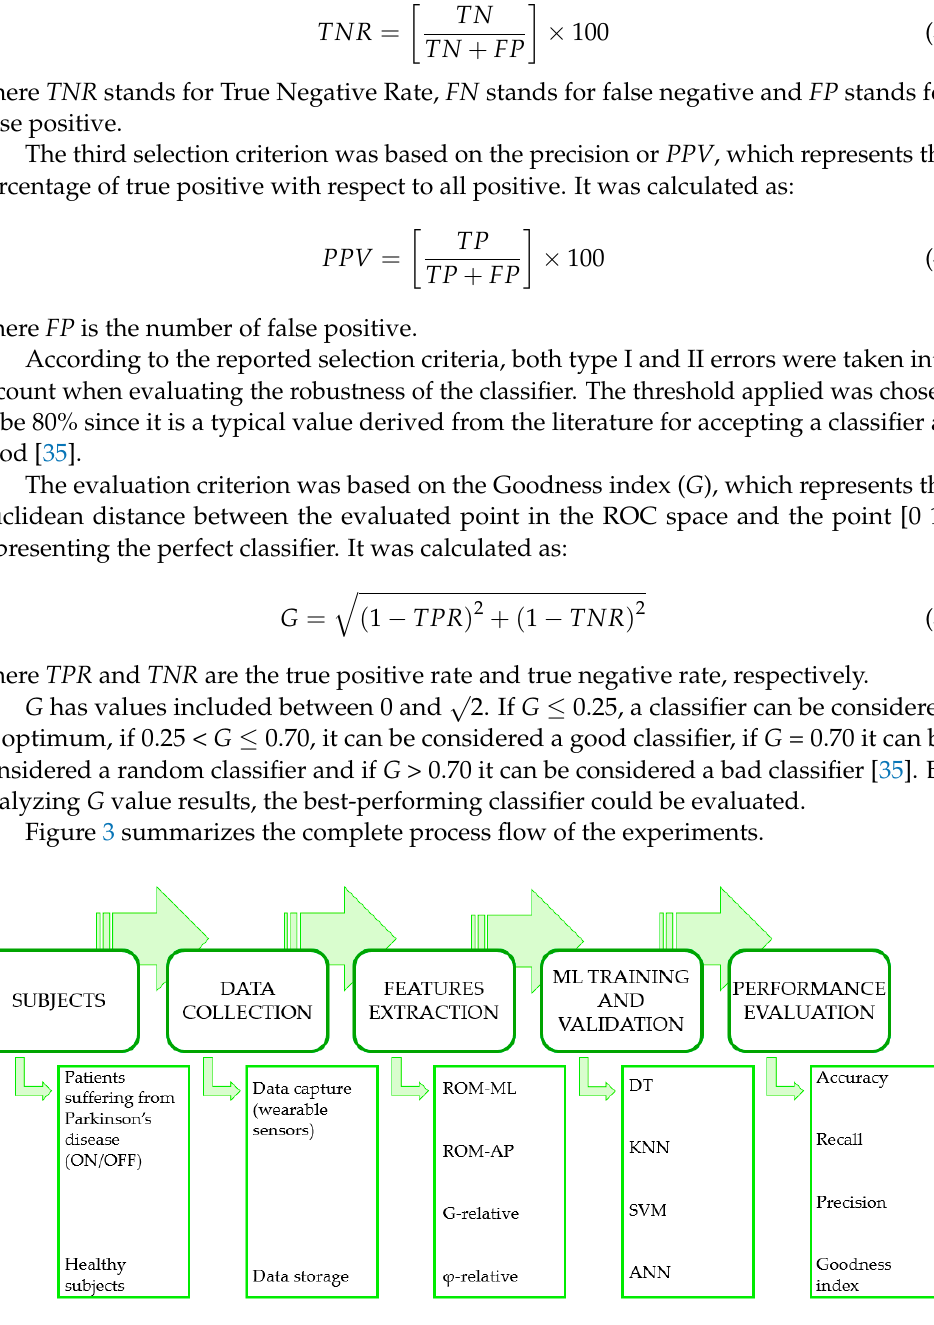
8 of 17 Figure 2 . Flow chart for the identification of the best-performing classifiers. The first selection criterion was based on accuracy, which represents the percentage of correct classification. It was calculated as: 𝐴𝐶𝐶 = (cid:3428)𝑇𝑃 + 𝑇𝑁 𝑃 + 𝑁 (cid:3432) × 100